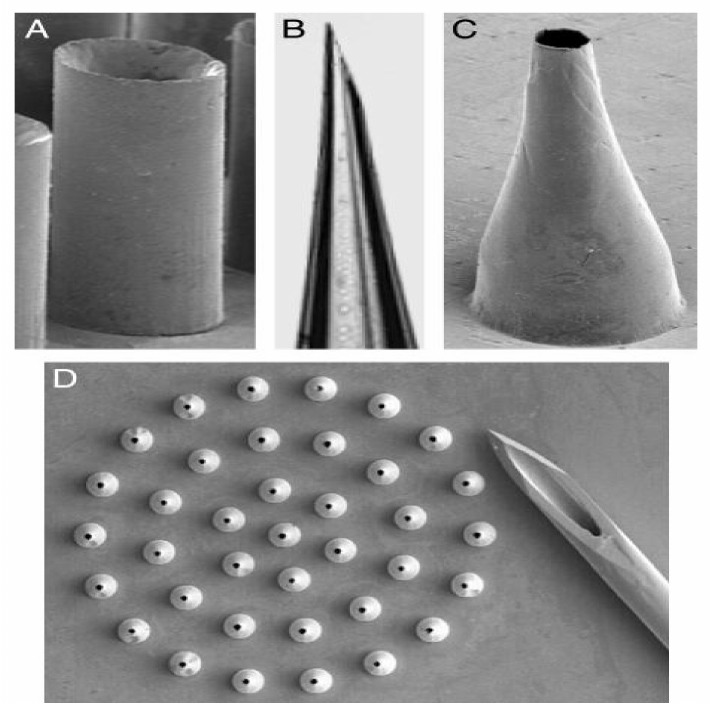
Figure 7. Hollow microneedles fabricated out of silicon, metal, and glass imaged by optical and scanning electron microscopy. ( A ) Straight-walled metal microneedle from a 100-needle array fabricated by electrodeposition onto a polymer mold (200 µ m tall). ( B ) Tip of a tapered, beveled, glass microneedle made by conventional micropipette puller (900 µ m length shown). ( C ) Tapered, metal microneedle (500 µ m tall) from a 37-needle array made by electrodeposition onto a polymeric mold. ( D ) Array of tapered metal microneedles (500 µ m height) shown next to the tip of a 26-gauge hypodermic needle [74]. Reproduced with permission from Devin V. McAllister et al.,